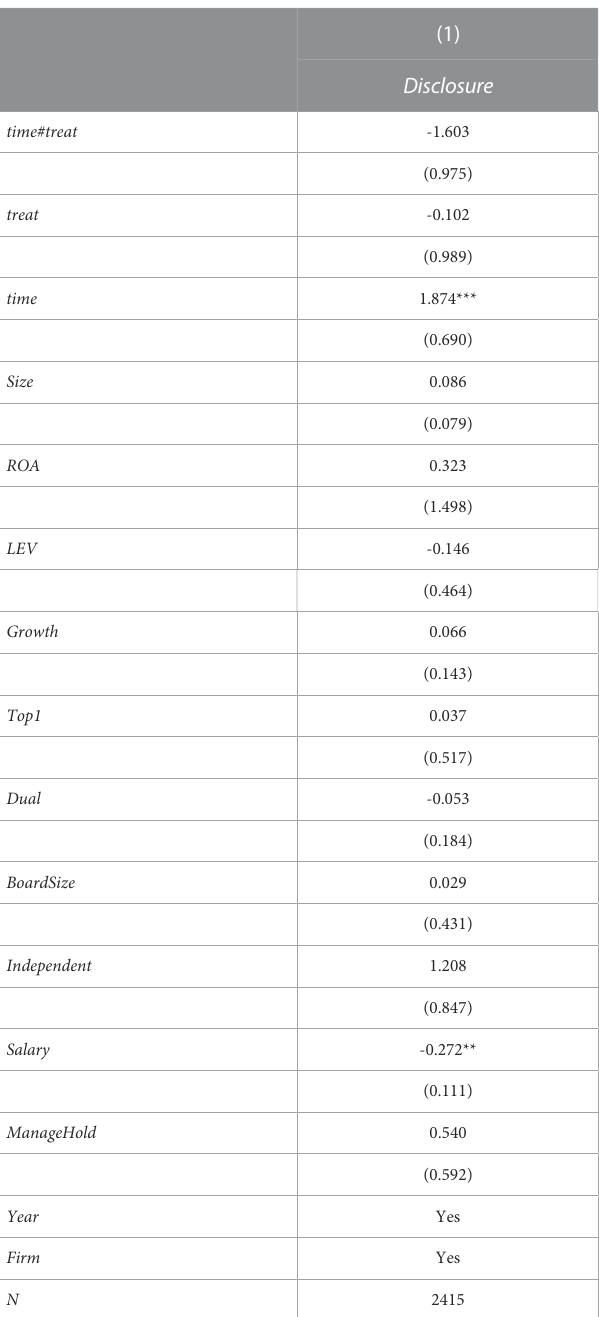
TABLE 11 Placebo Test, 2006 – 2013: This table shows the placebo test result based on a DID model. Disclosure represents fi rm-level ESG disclosure. time#treat is an interaction term by multiplying time and treat to capture the policy effect of double difference, where treat is a dummy variable that takes the value 1 if the fi rm is in the target stock list, and 0 otherwise, and time is a dummy variable that takes the value 1 if the year is after 2009, and 0 otherwise. The sample period ranges from 2006 to 2013. The control variablesinclude fi rmsize( Size ),returnontotalassets( ROA ), fi nancialleverage ( LEV ), growth rate ( Growth ), ownership concentration ( Top 1), integration of two positions ( Dual ),board size ( BoardSize ), the ratio of independent directors ( Independent ), top three executives ’ compensation ( Salary ), and management shareholding ratio ( ManageHold ). Year fi xed effects( Year ) and fi rm fi xed effects( Firm ) are both included. Refer to Table 1 for detailed variable de fi nitions. t -statistics are reported in parentheses.***, ** and * denote signi fi cance levels at 1%, 5% and 10%,